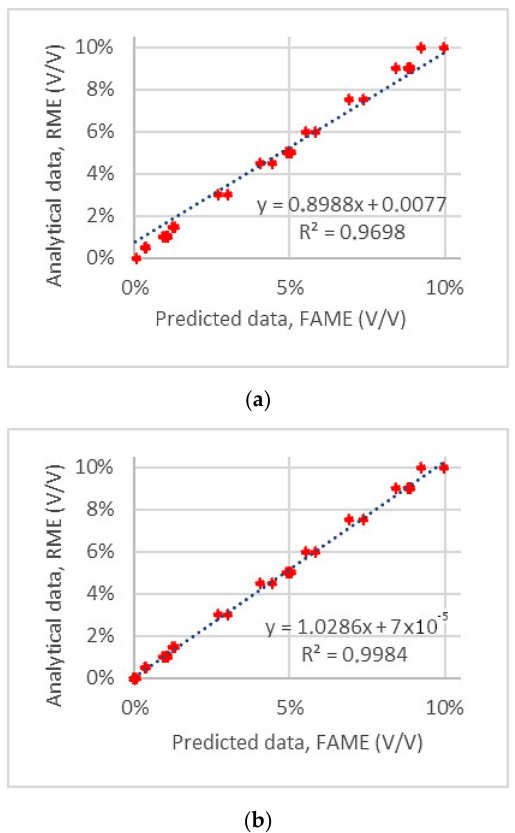
Figure 6. Analytical concentration values of all validation samples versus predicted values using FAME quantification PLS model: ( a )—PLS model predictions, ( b )—PLS model after truncating predicted negative concentrations to zeros.